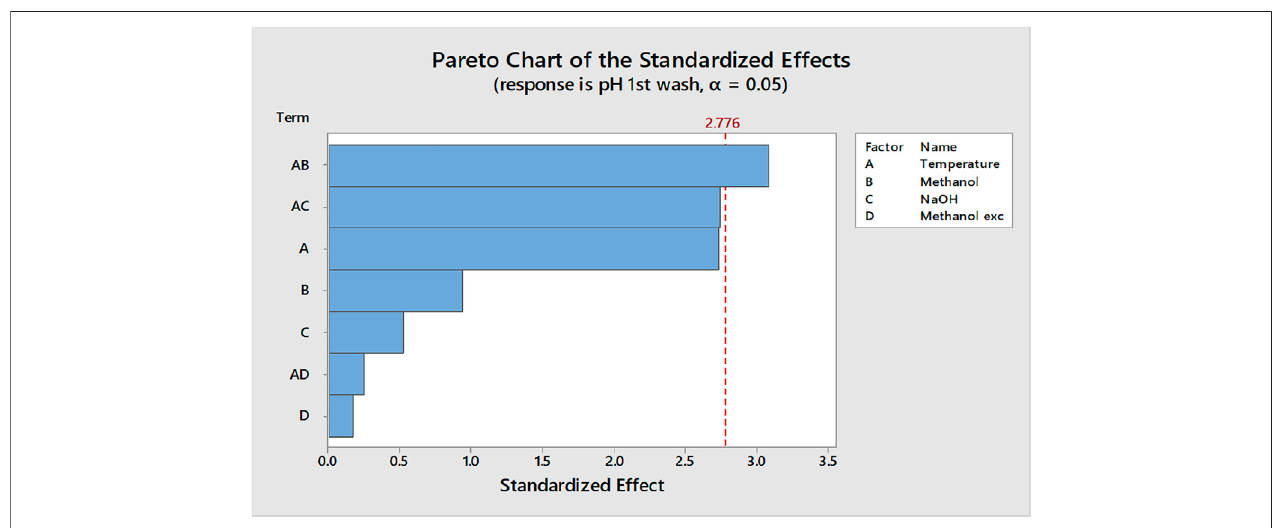
FIGURE 2 | Pareto diagram for pH response at fi rst wash.